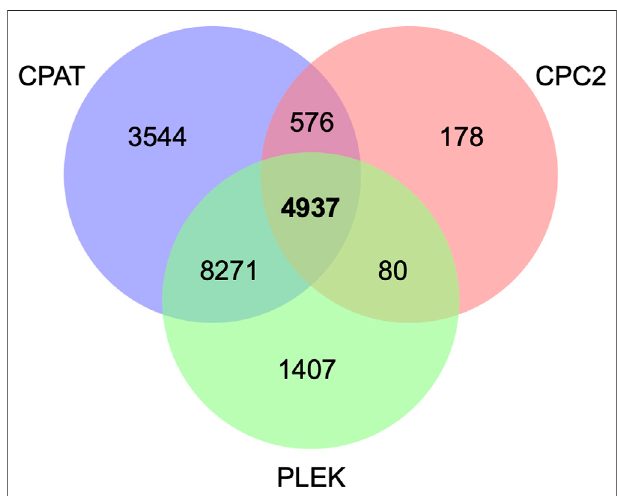
FIGURE 1 | Putative long noncoding RNAs based on CPC2, PLEK, and CPAT tools.